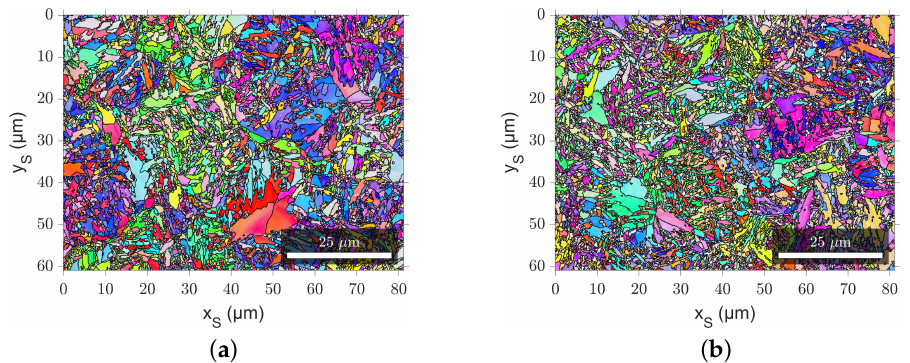
Figure A2. Martensite orientation map of 17NiCrMo6-4 (B) ( a ) 18 bar Direct and ( b ) 6 bar Stop.